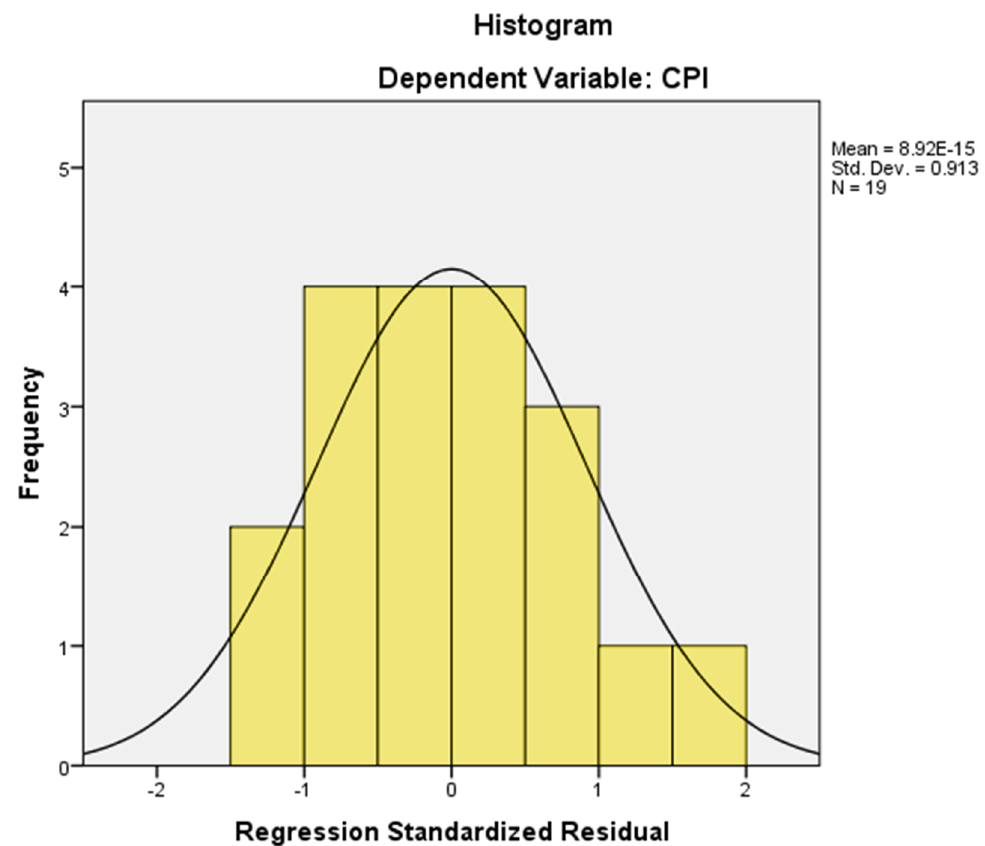
Figure A1. Normality test.